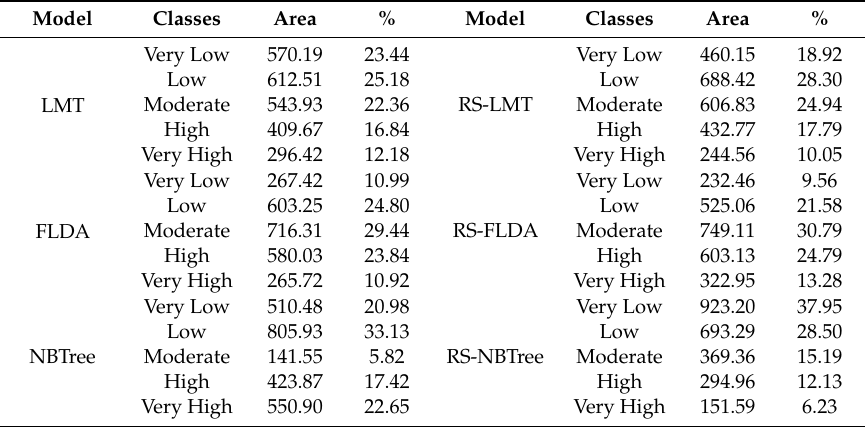
Table 5. Area and percentage of susceptibility classes in di ff erent